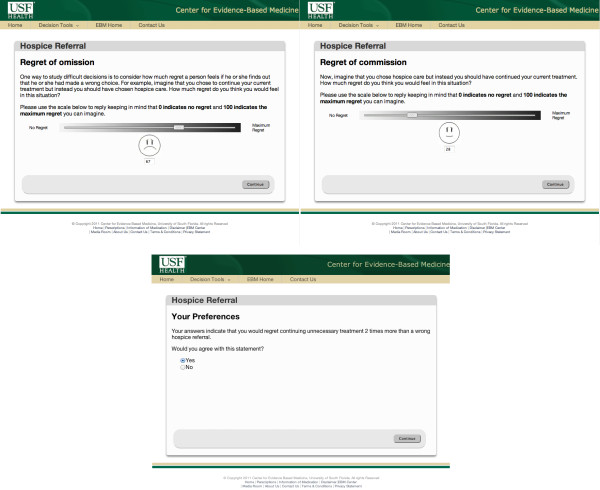
Elicitation of threshold probability. The user (patient/surrogate/physician) weighs the two alternative management strategies in terms of regret.